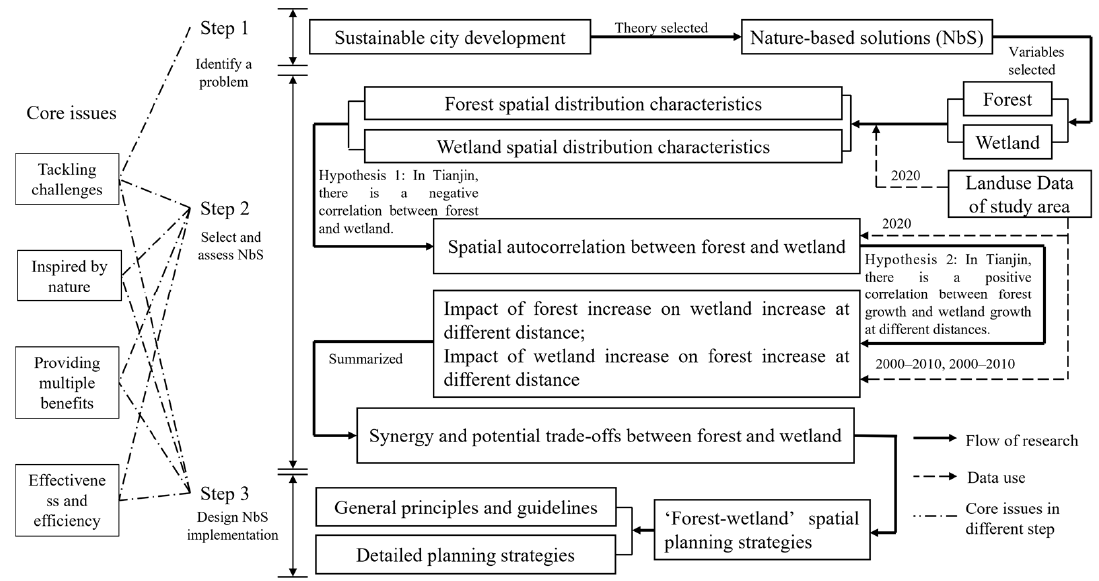
Figure 3. Flow chart of research approach of “forest-wetland” NbS.